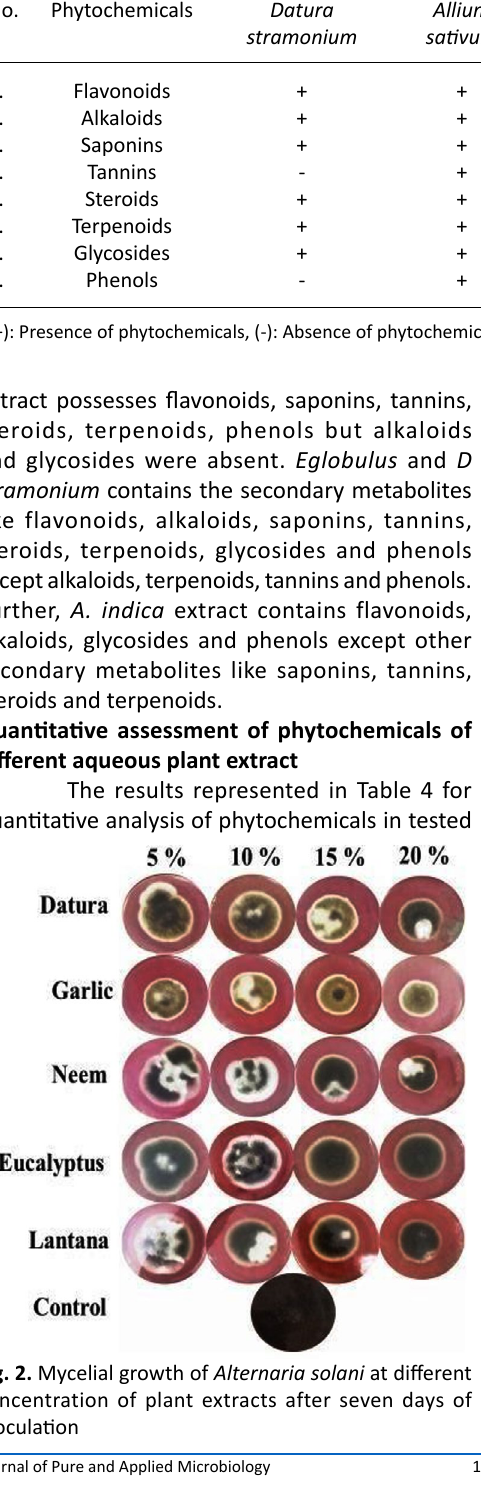
table 3. Qualitative analysis of phytochemicals in aqueous plant extracts No.